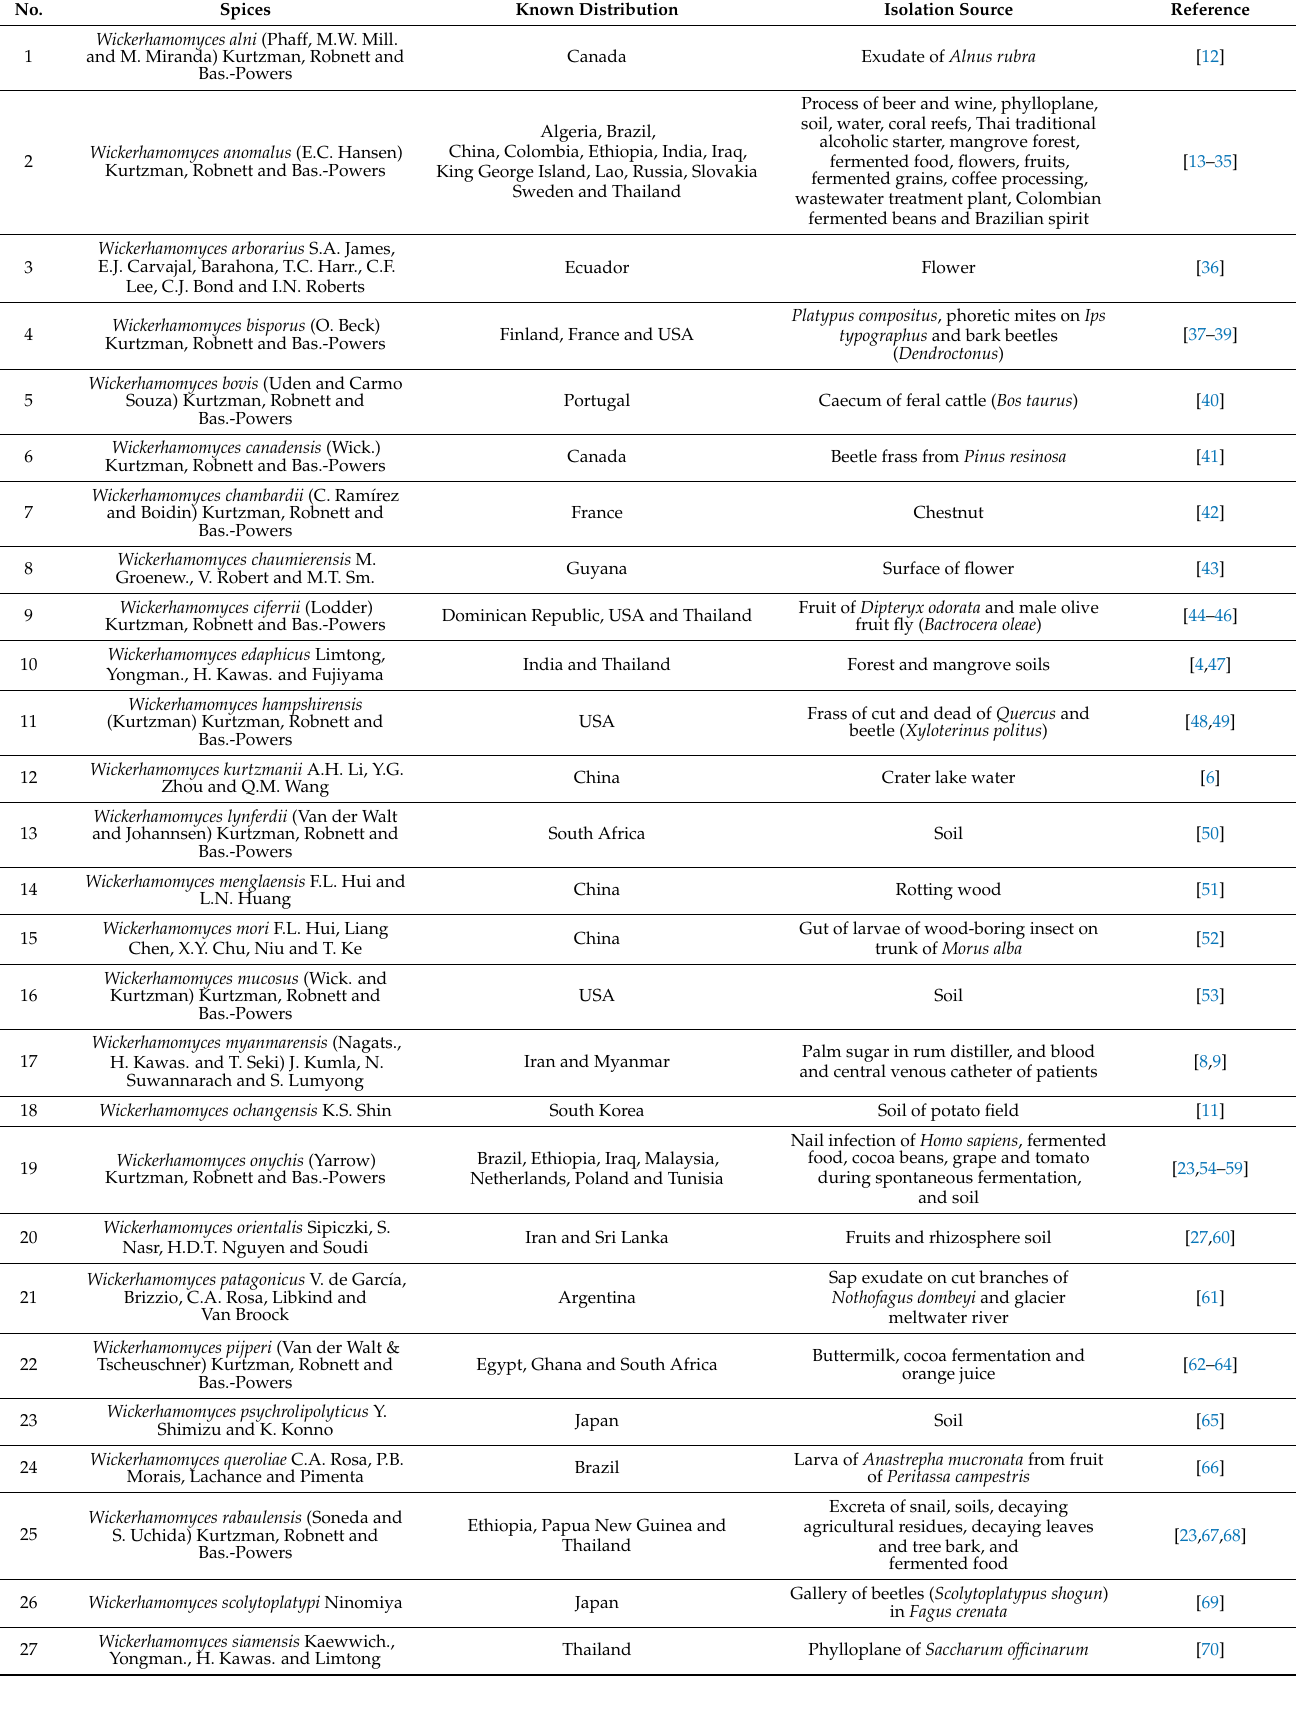
Table 1. Global distribution and isolation sources of Wickerhamomyces